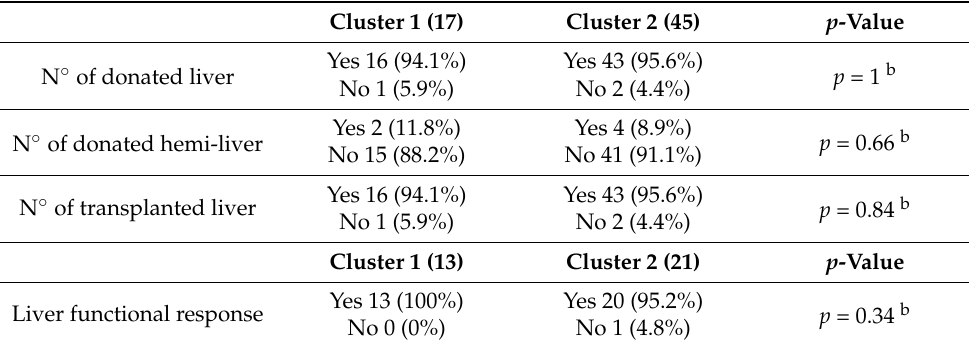
Table 3. Outcomes of transplanted liver from trauma donors